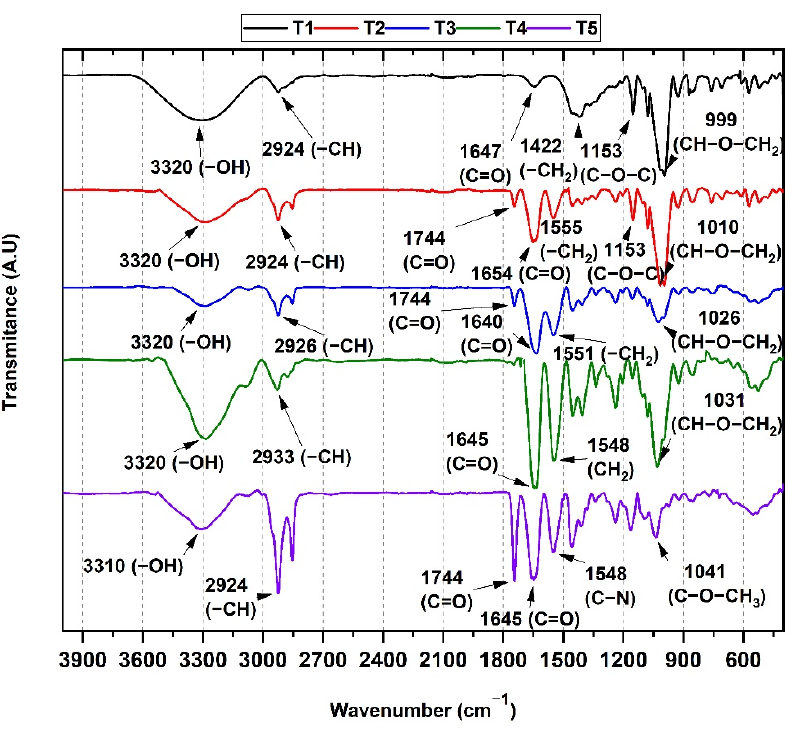
Figure 1. FTIR spectrum for the five composite membranes (T1–T5 according to Table 1). T1 (100%CS); T2 (25%G:75%CS); T3 (50%G:50%CS); T4 (75%G:25%CS); T5 (100%G).